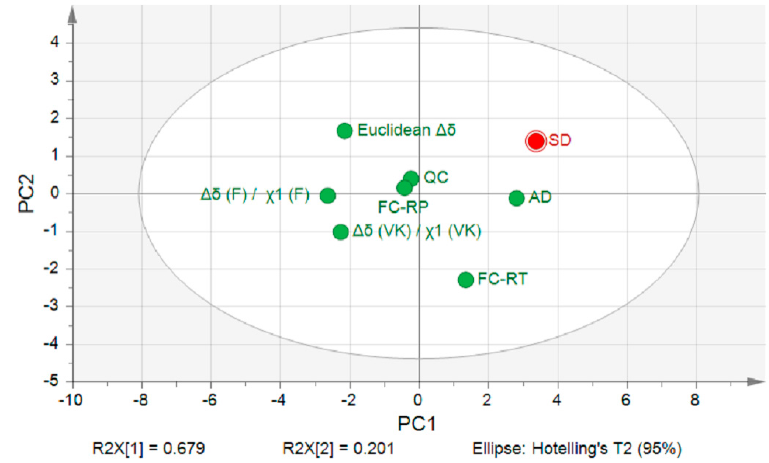
Figure 12. PCA score plot analysis of polymer rank order for thermodynamic models, film casting performed: at RT (FC-RT) and under reduced pressure (FC-RP); (QC) quench cooling, (AD) atomization screening device, and (SD) spray dryer for IBU, NAP, CAR, and ITR with the set of polymers tested.